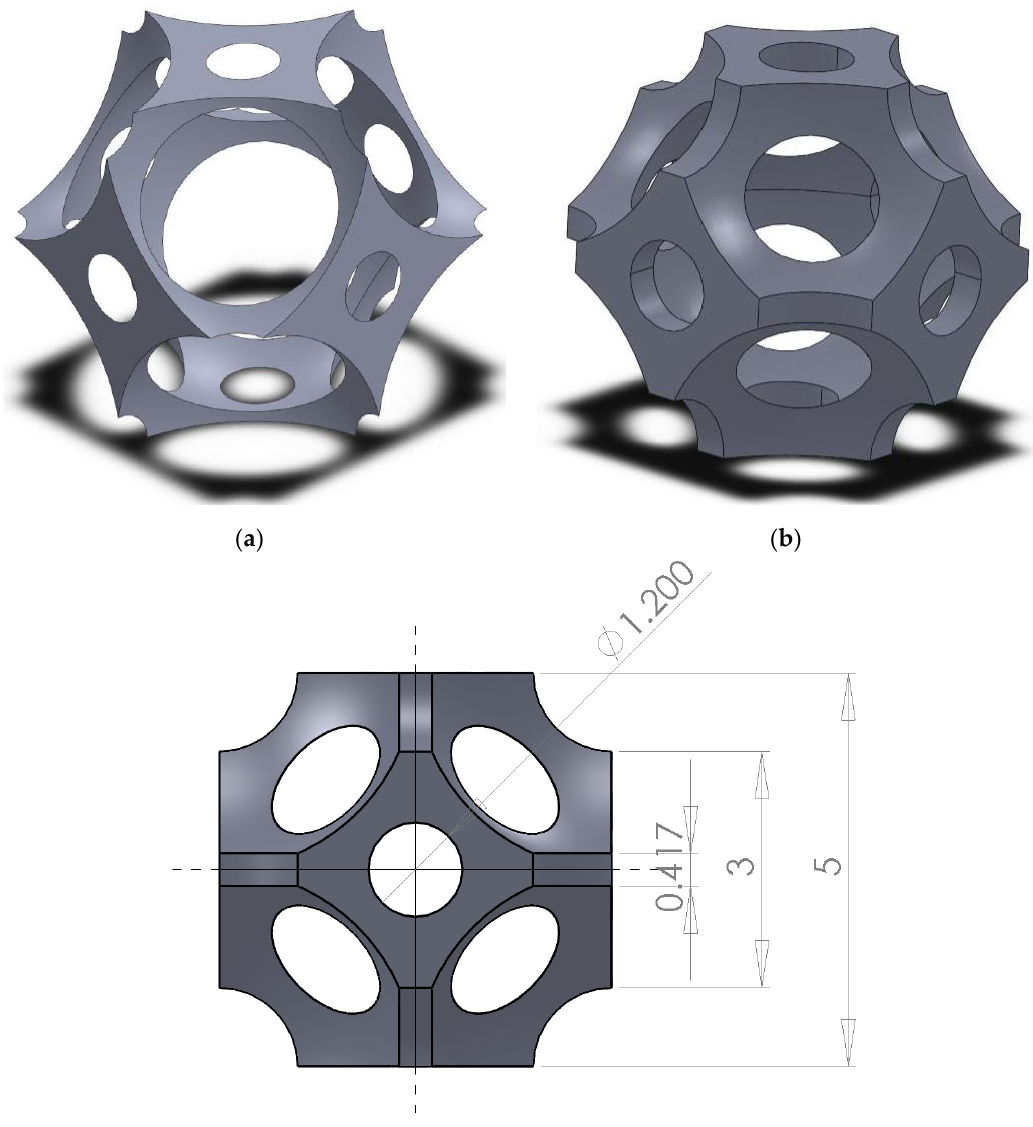
Figure 1. ( a ) BCC structure; ( b ) modified BCC structure; ( c ) lateral view of the modified BCC structure with dimensions.